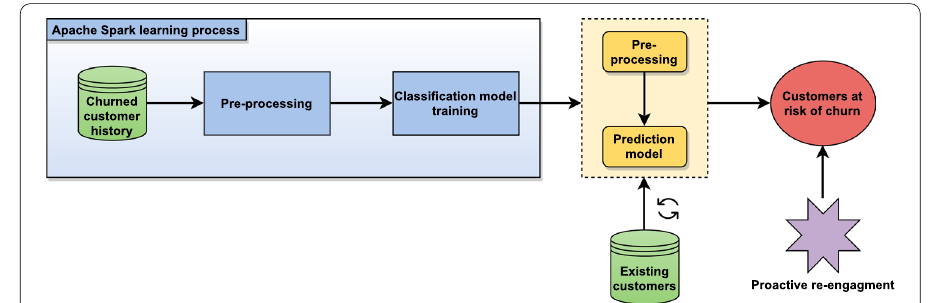
Fig. 4 Architecture of the proposed Spark